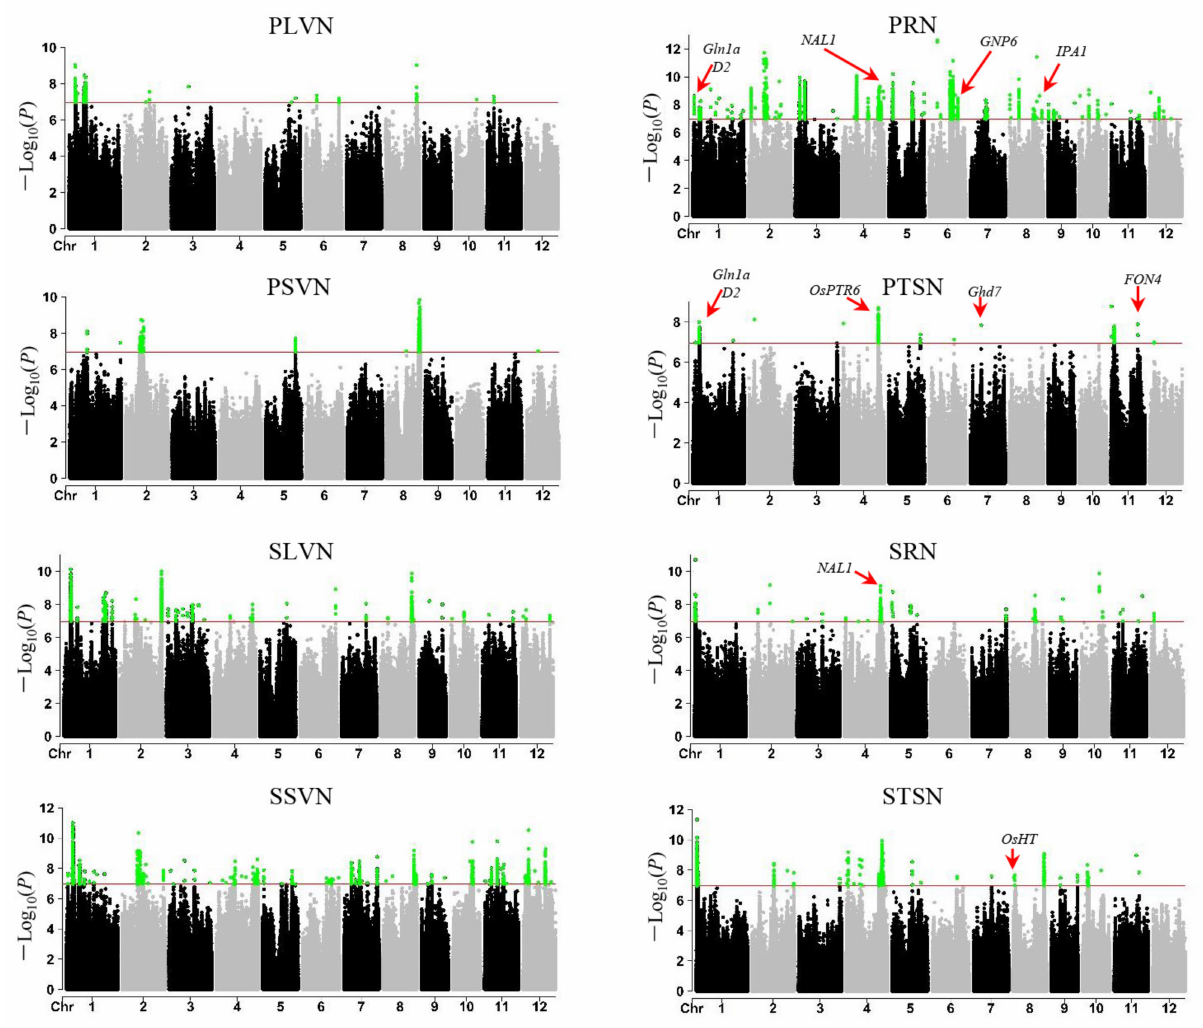
Figure 3. Manhattan plots of genome-wide association for flow- and sink-related traits in the 440 panel. Orange dashed line in Manhattan plots represents the significant thresholds (–log 10 P = 6.95). Highlighted SNPs in light green are significantly associated with the measured